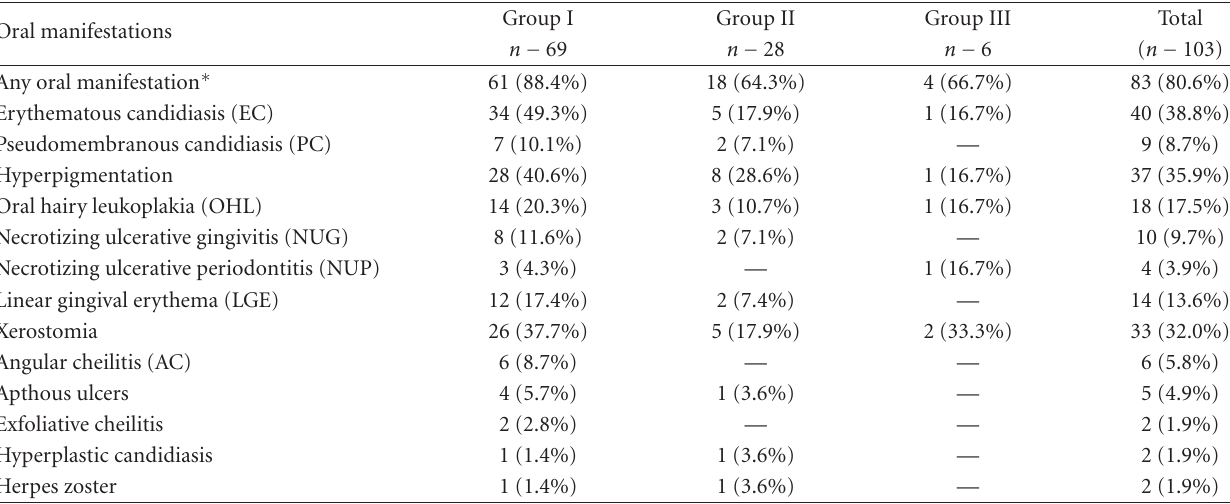
Table 3: Oral manifestations in relation to CD4/CD8